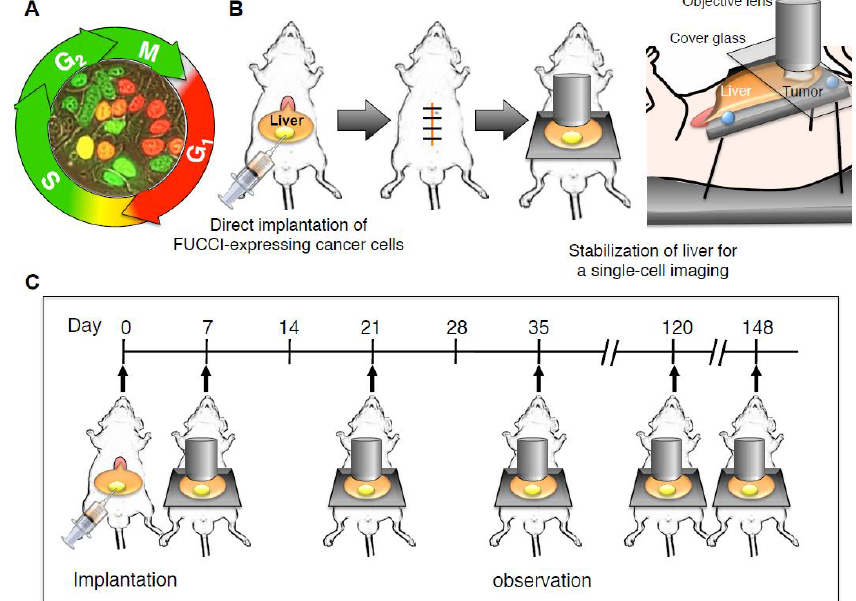
Figure 1 . An abdominal skin-flap window for longitudinal intravital imaging of fluorescence ubiquitination-based cell cycle indicator (FUCCI)-expressing cancer cells in the liver of a live mouse. ( A ) FUCCI-expressing MKN45 gastric cancer cells in G 0 /G 1 , S, or G 2 /M phases are red, yellow, or green, respectively. ( B ) The schematic diagram shows the method of longitudinal intravital confocal laser scanning microscopy (CLSM) imaging of FUCCI-expressing gastric-cancer cells growing in the liver using a skin-flap window. All animal procedures were performed under anesthesia using s.c.